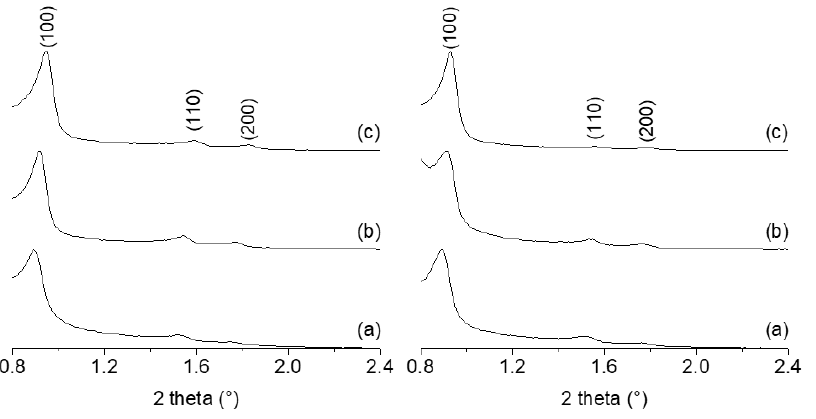
Figure 4. Low-angle X-ray diffraction patterns of x Al_SBA-15 ( a ), Imi/ x Al_SBA-15 ( b ), and MgO/ x Al_SBA-15 ( c ). Left : x = 1; right : x = 5.